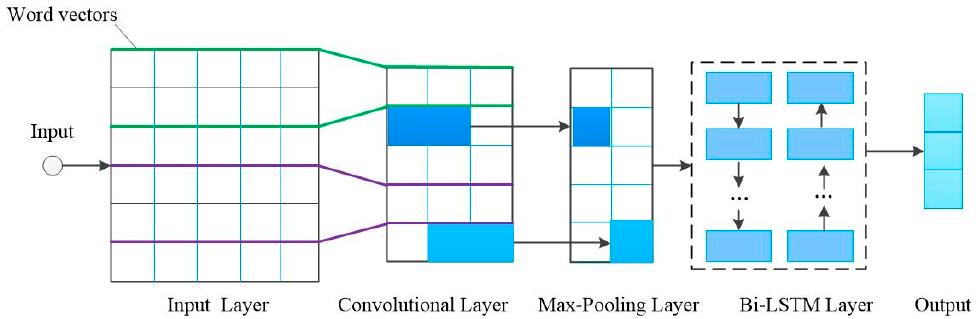
Figure 1. Architecture of the WSM-CNN-LSTM model.